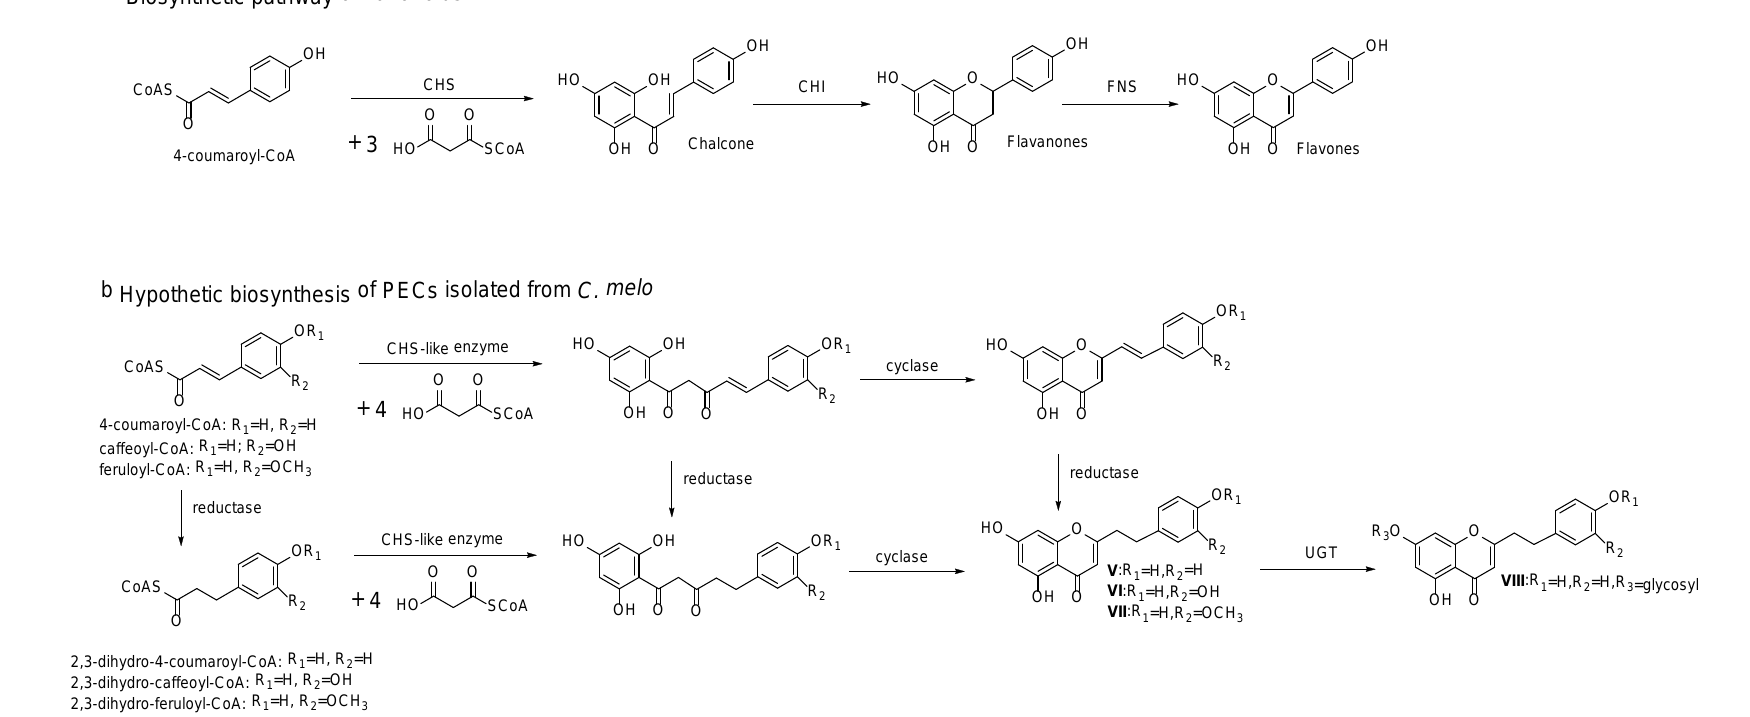
Figure 6. Hypothetic biosynthesis of PECs isolated from C. melo and comparison of the biosynthesis of flavonoids.